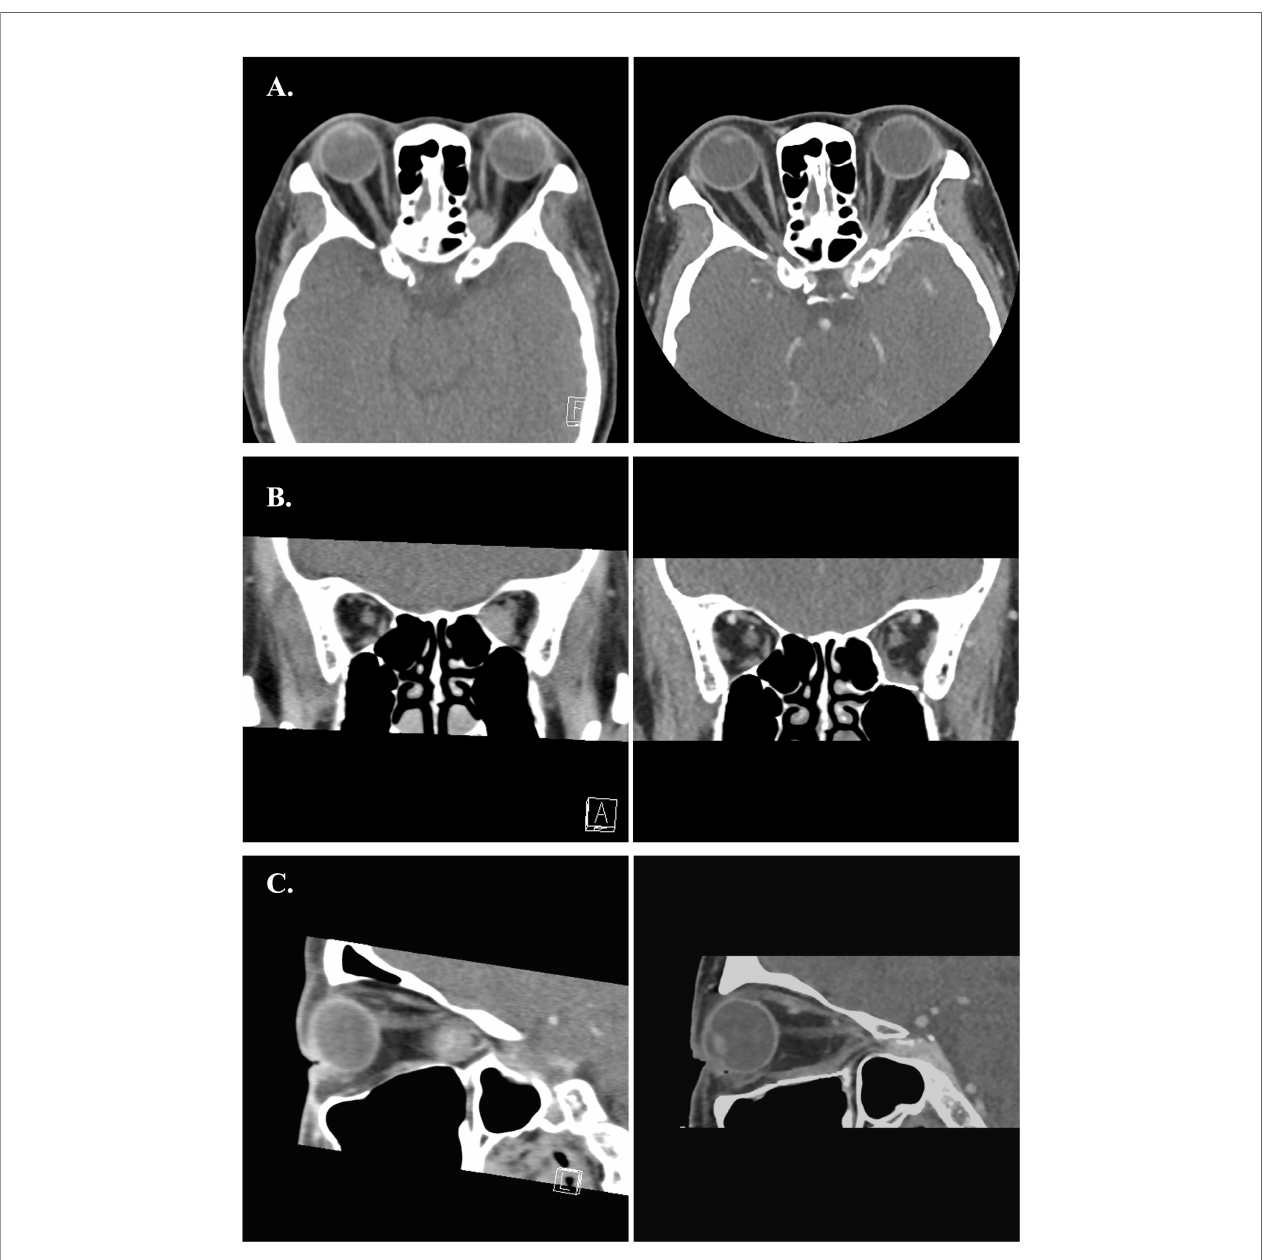
FIGURE 9 | (A – C) Preoperative and postoperative images of Case 2. The left-side axial, coronal and sagittal images were the preoperative CT scans. The right-side postoperative CT images showed normal extraocular muscles position and well restored orbital volume with Titanium